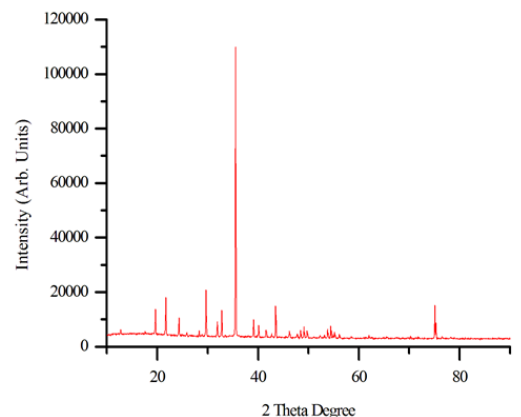
Fig. 6. X-Ray diffraction peaks of G. applanatum extract mediate nanoparticles